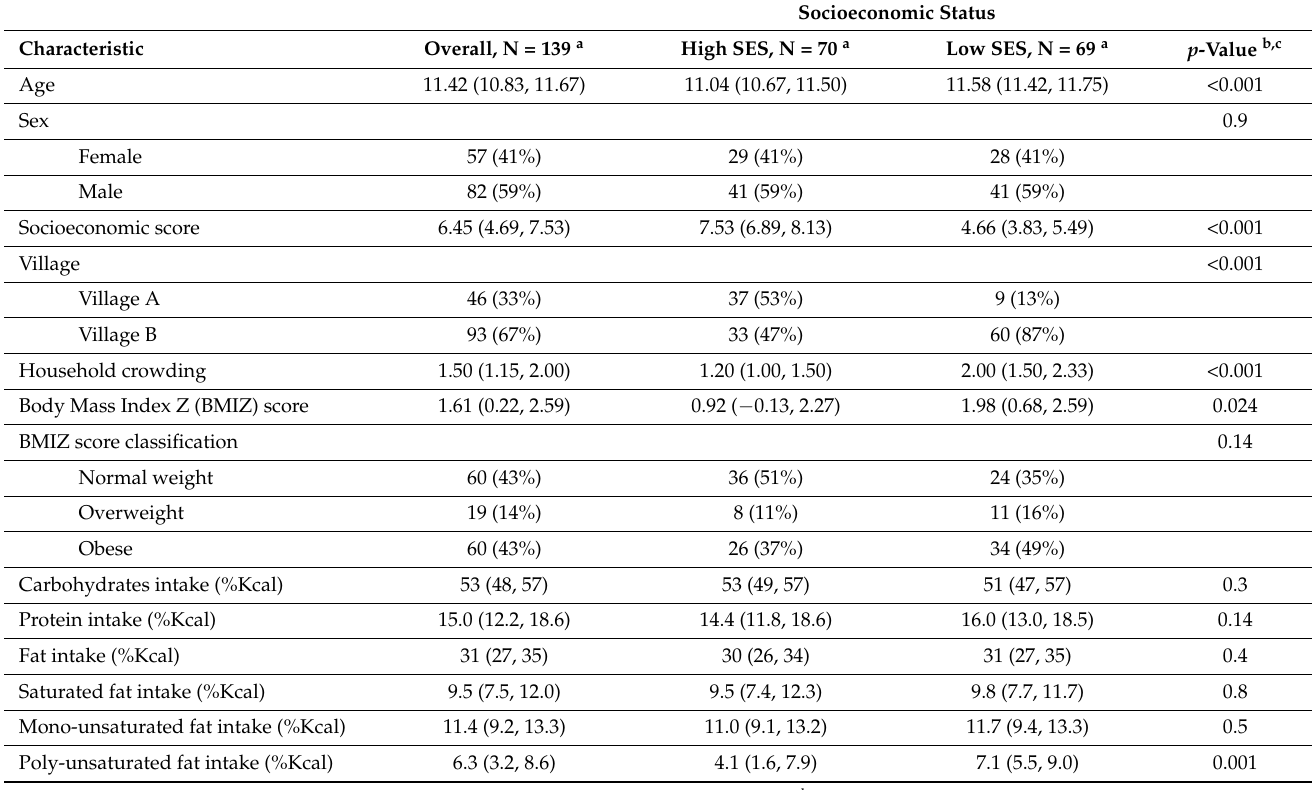
Table 1. Demographic characteristics and dietary intake of the study participants.